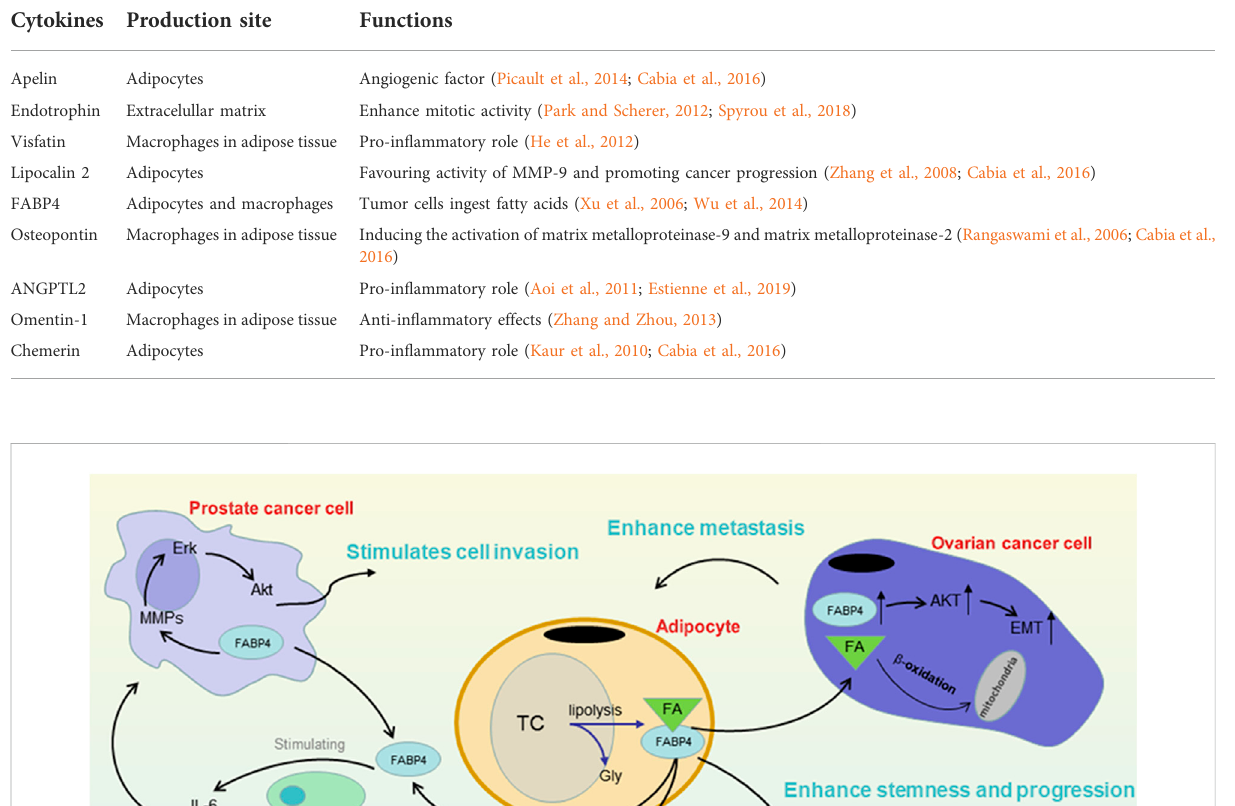
TABLE 2 Novel adipokines that may be involved in promoting cancer.